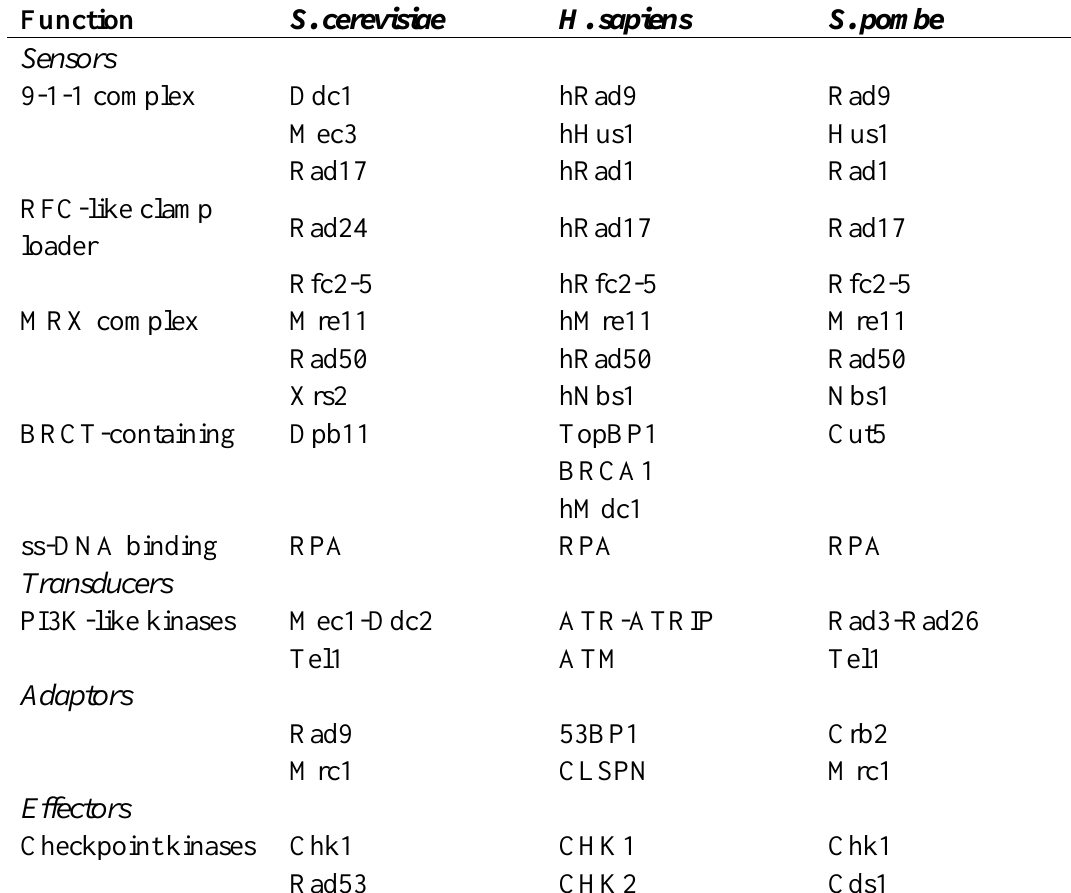
Table 1. DNA damage checkpoint related factors.